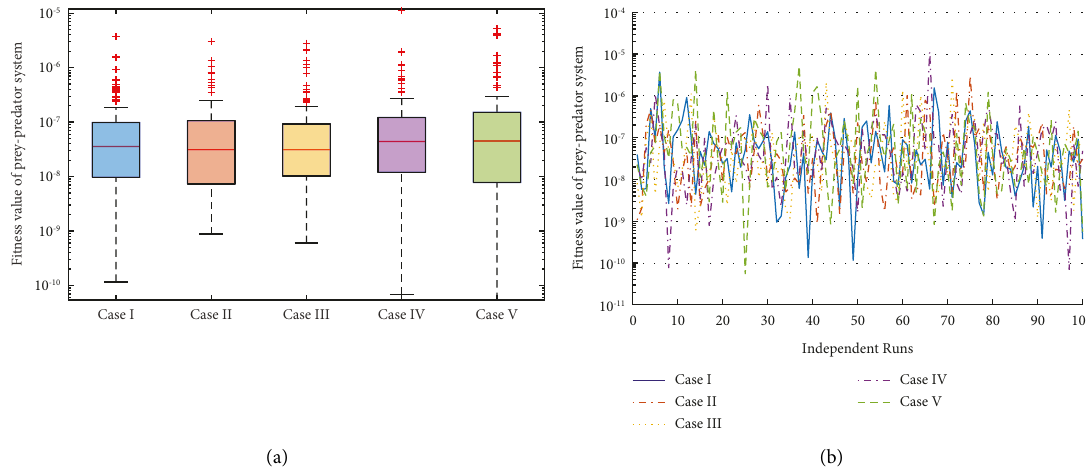
Figure 5: Comparison between the box plots and the convergence graph of fitness evaluation over 100 independent runs for the prey- predator model with variations in the intrinsic growth rate of local prey. (a) Box plots for fitness evaluation of the prey-predator model with variations in α (b) Convergence of the fitness value of the prey-predator model with variations in α 1 Table 10: Convergence analysis for variation in α